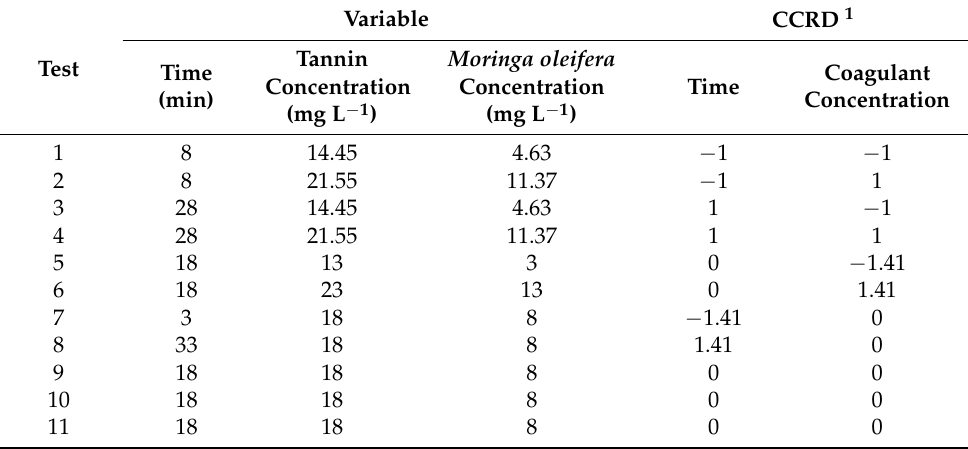
Table 2. Concentrations and sedimentation times obtained by central composite rotational design (CCRD) in experiments of optimization of operational conditions using natural coagulants.